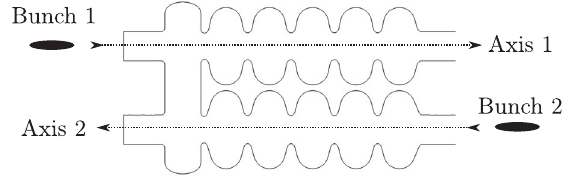
FIG. 12. A schematic of the simulations setup.